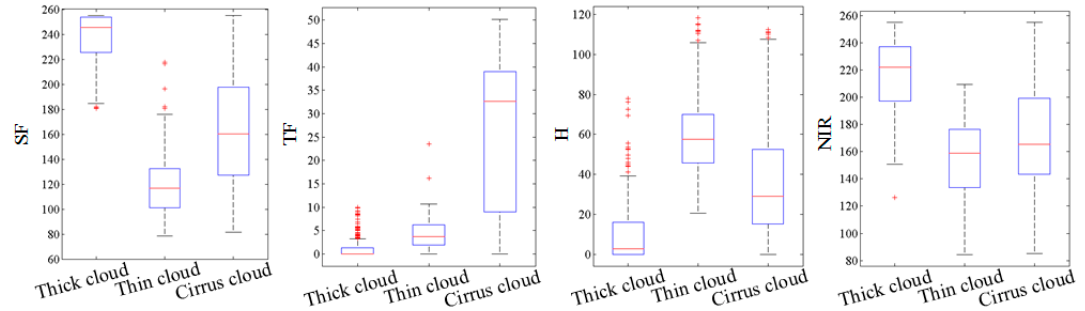
Figure 6. Statistics of the features information for the three cloud types. Each box plot shows the location of the 25, 50, and 75 percentiles using horizontal lines. The two whiskers cover the 99.3% percentile of the data, and the red “+” is the outlier outside the two whiskers.